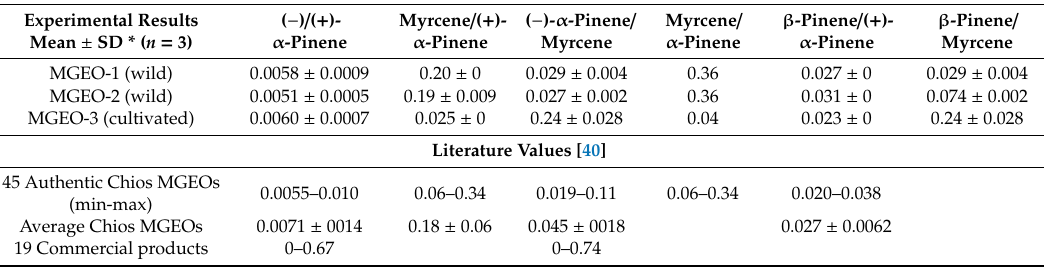
Table 3. Ratios of ( − ) / ( + )- α -pinene and ( − )- α -pinene / myrcene for the MGEOs-1–3. Experimental Results ( − ) / ( + )- α -Pinene Mean ± SD * ( n = 3) MGEO-1